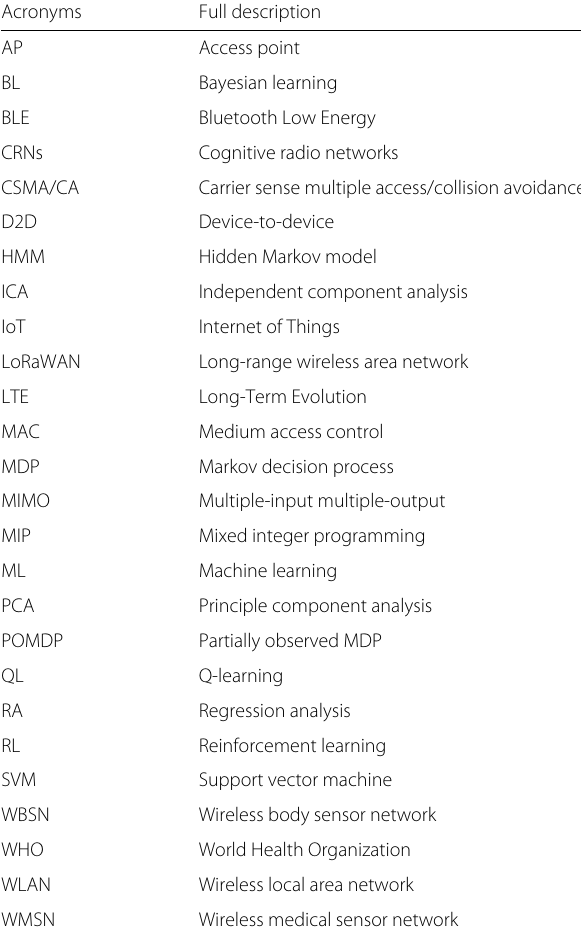
Table 1 List of acronyms used in this